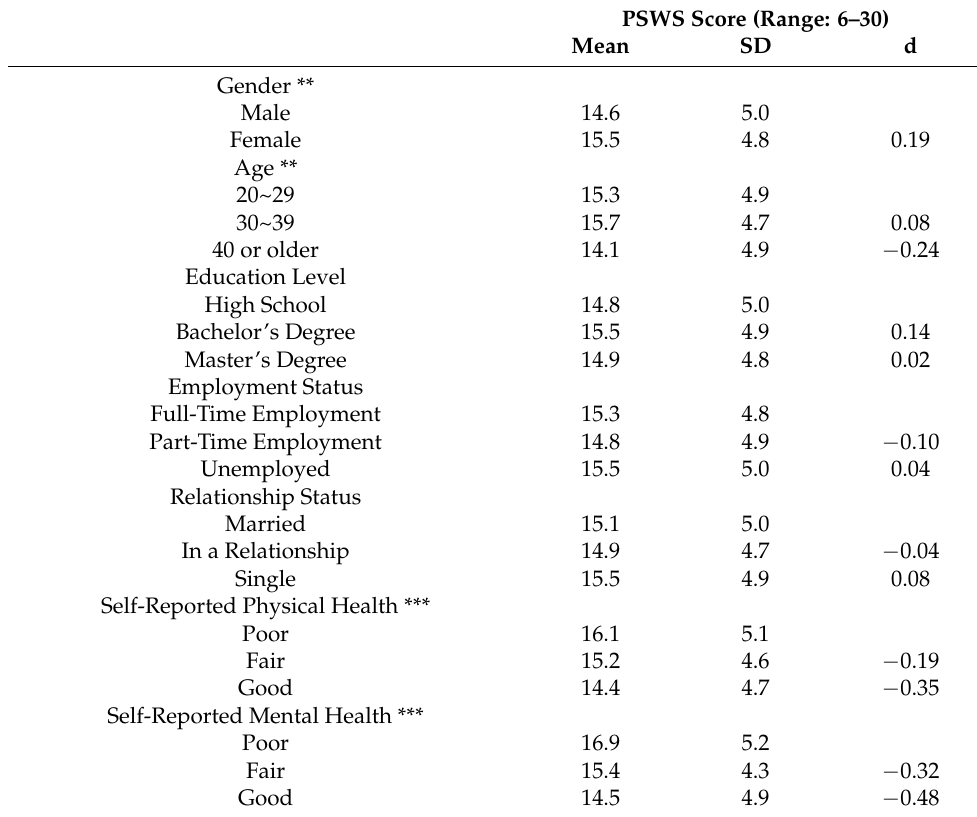
Table 2. Scores on the Problematic Series Watching Scale (PSWS) by sociodemographics and self- reported health